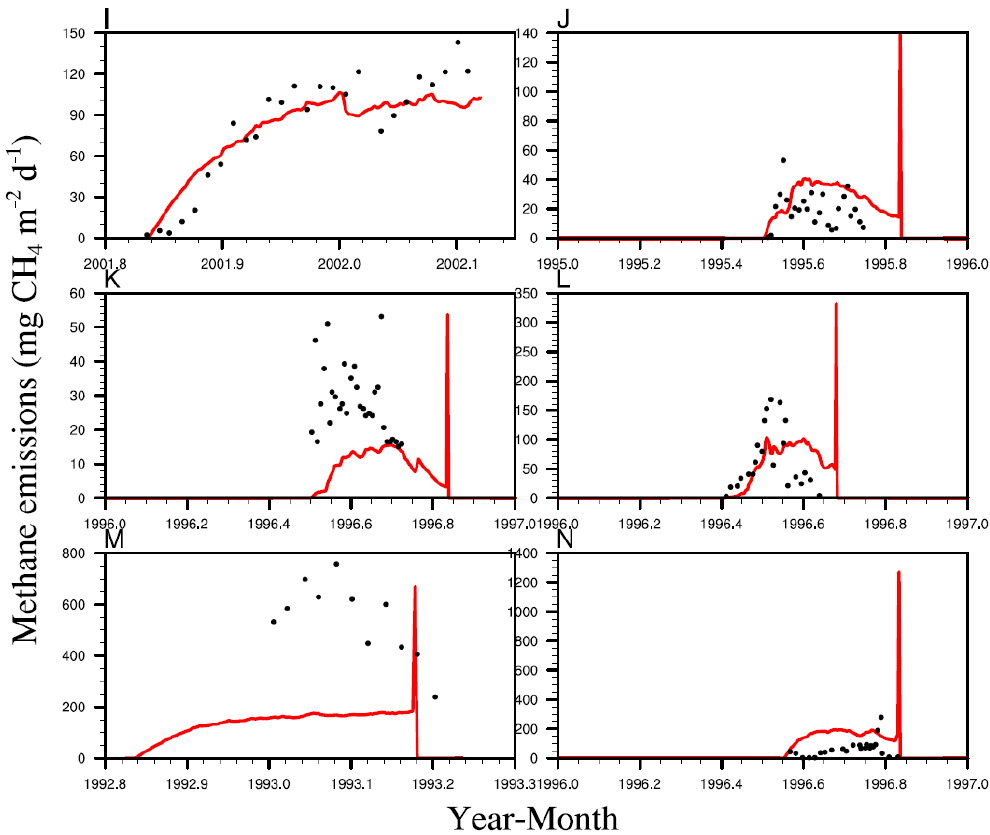
Fig. 10b. (continued). I : Central Java, Indonesia; J : New Delhi, India, 1995; K : New Delhi, India, 1996; L : Beijing, China; M : Lampung, Indonesia; N : Cuttack, Indonesia. Please see Table 1 for site